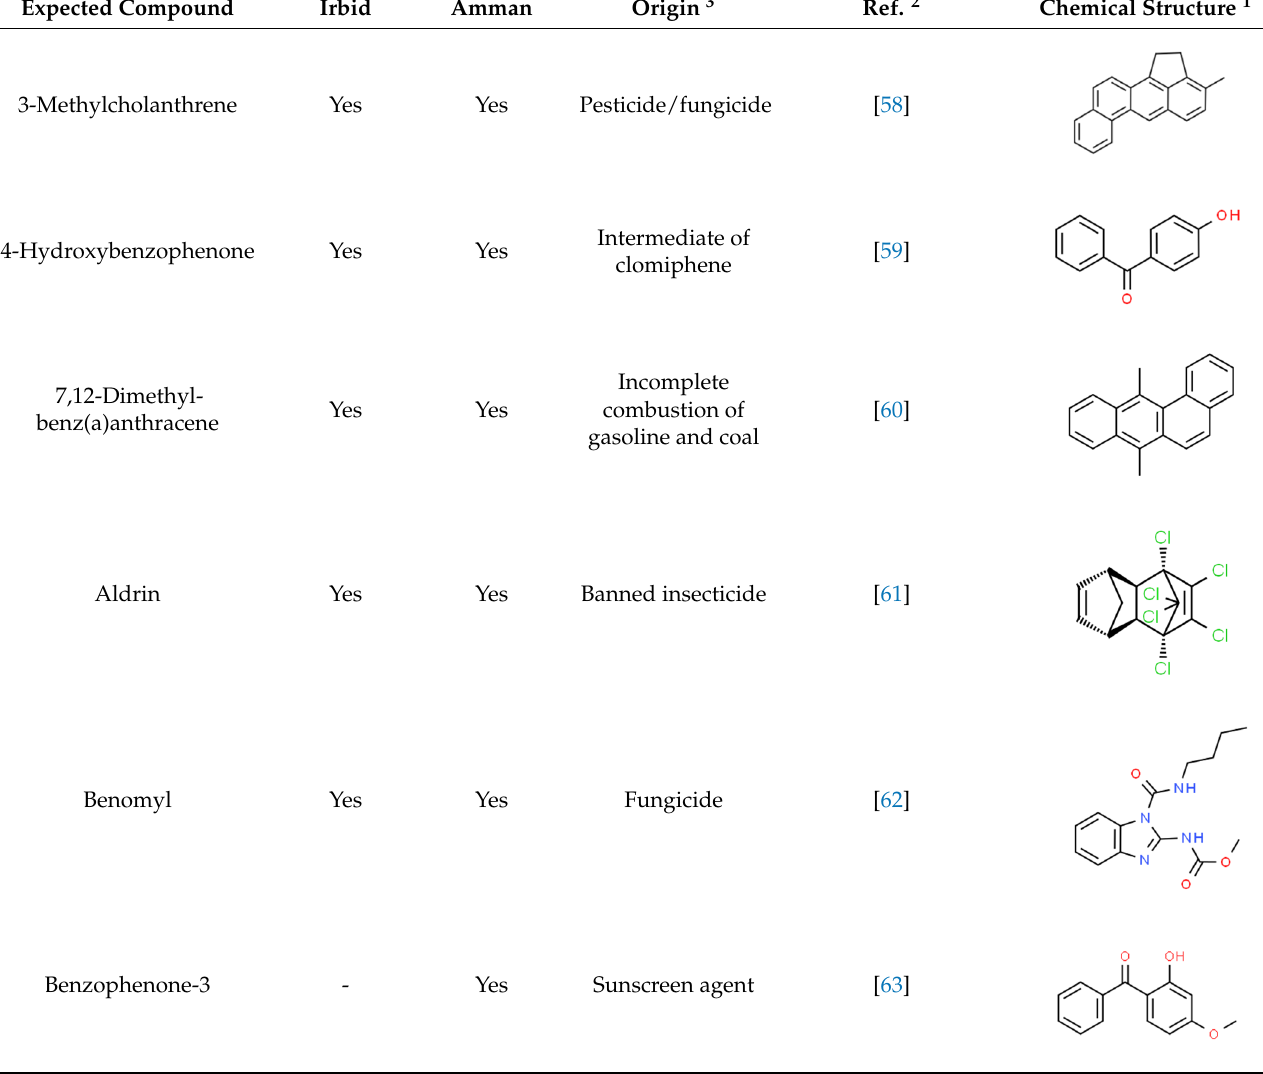
Table 3. Detected xenoestrogens in tap Table 3. Detected xenoestrogens in tap water. Table 3. Detected xenoestrogens in tap water. Table 3. Detected xenoestrogens in tap water. Table 3. Detected xenoestrogens in tap water. Table 3. Detected xenoestrogens in tap water. Table 3. Detected xenoestrogens in tap water.